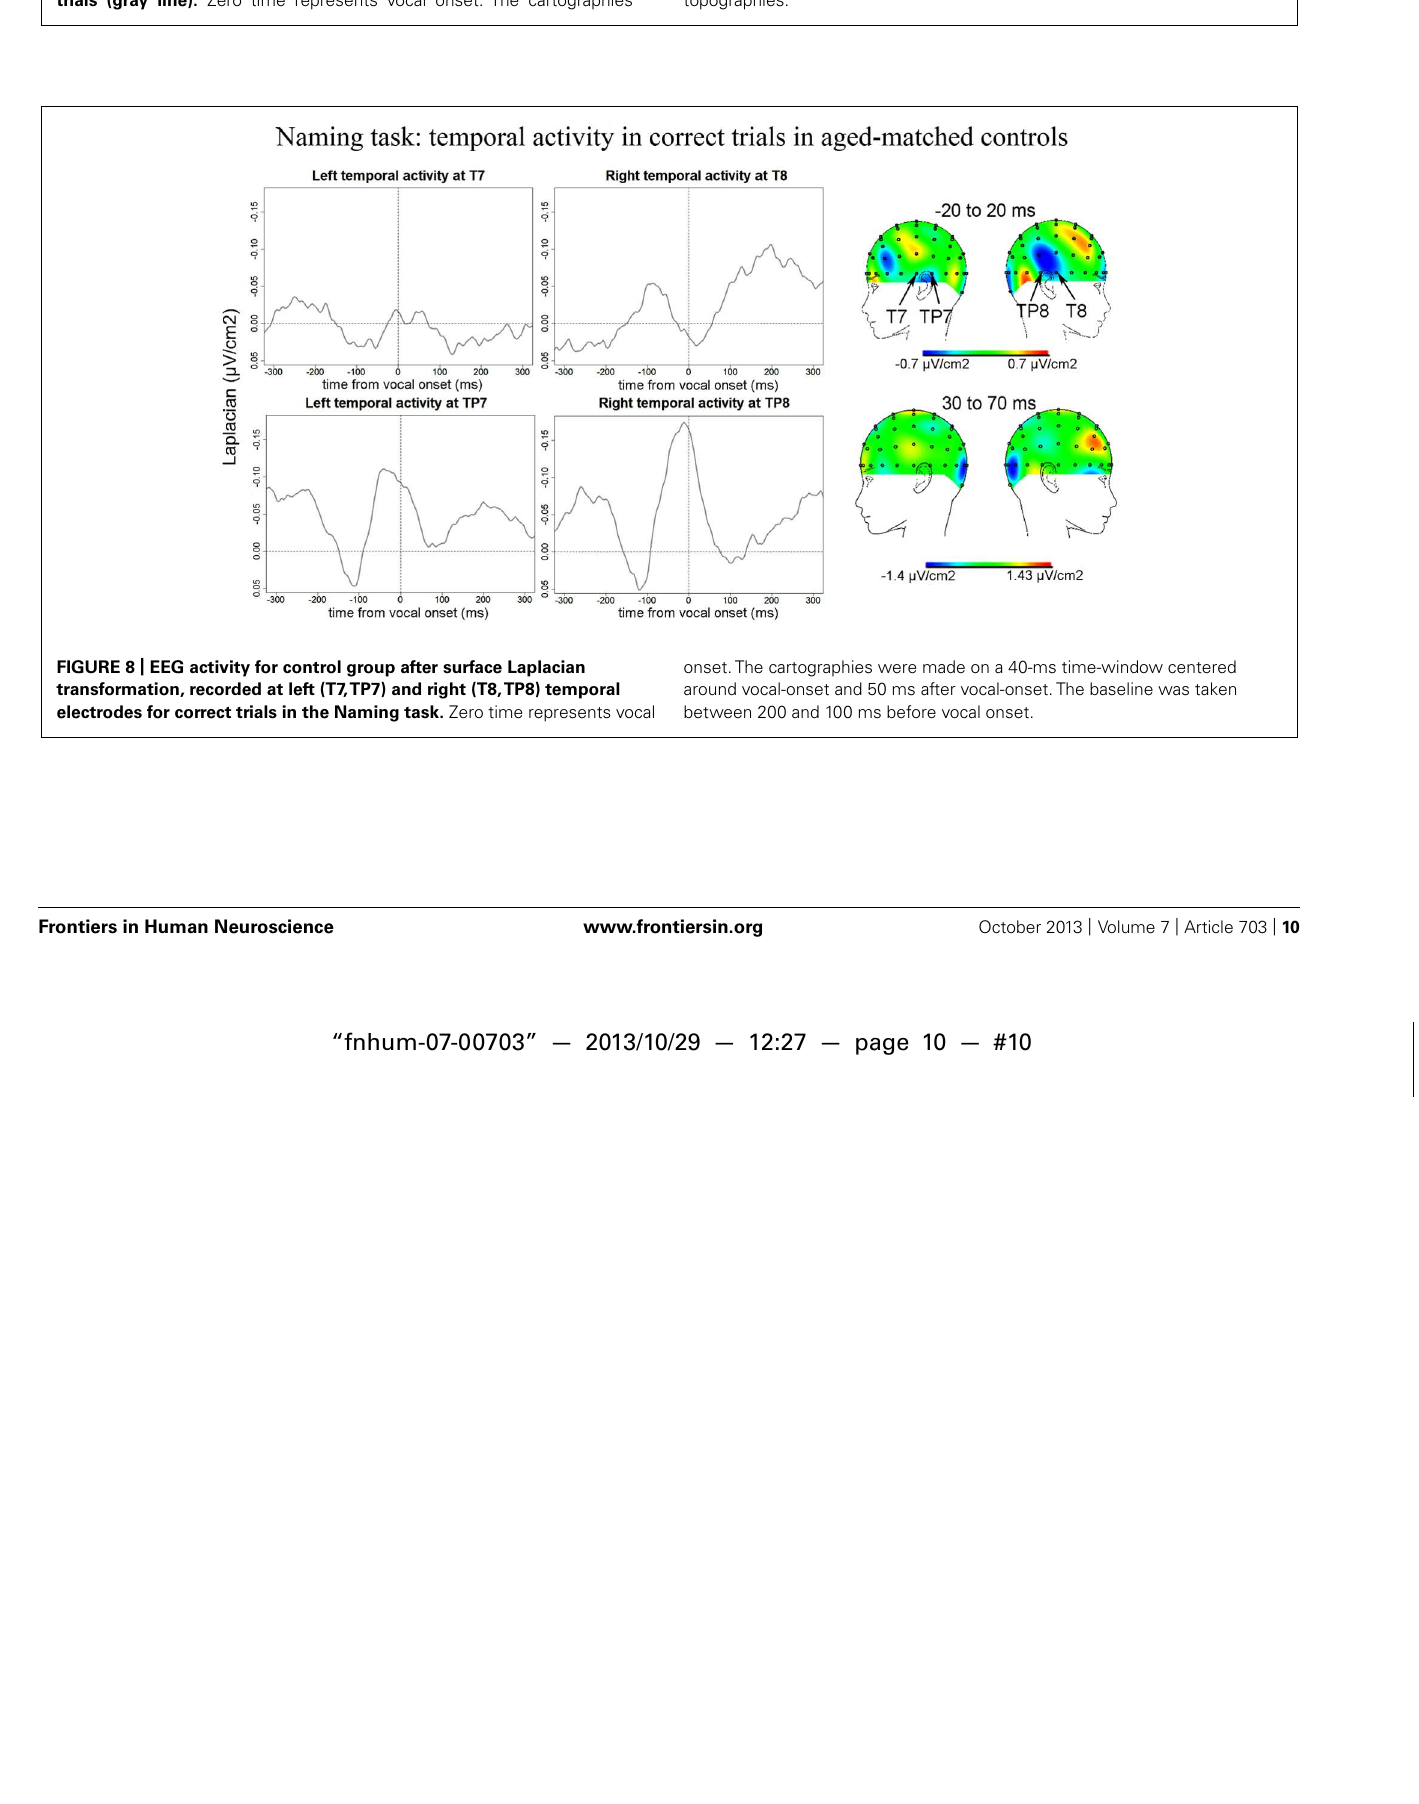
were made on 40 ms time-windows centered on vocal-onset and 50 ms after vocal-onset. The baseline was taken between 200 and 100 ms before vocal onset. The same scale was used for all topographies.